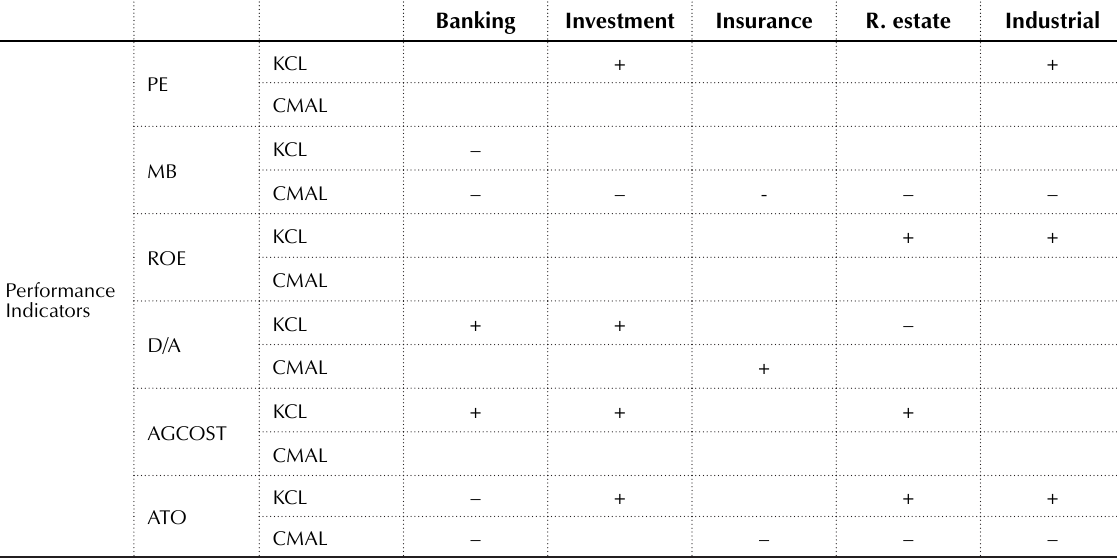
Robust Std. err. coef.